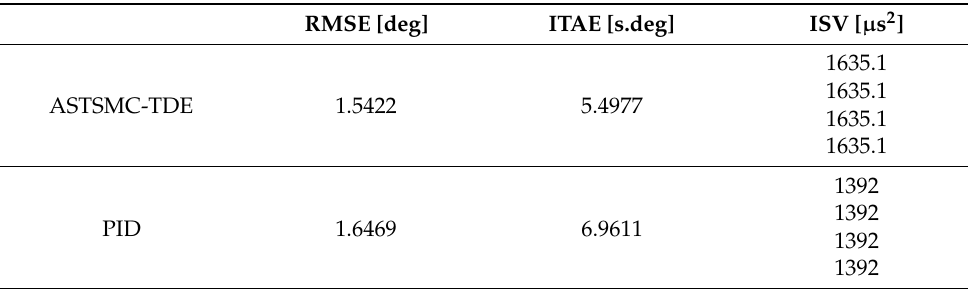
Figure 11. The performance indices: ( a ) ISV values of the proposed controller; ( b ) ISV values of the PID. Table 1. RMSE, ITAE, and ISV values in NM mode.